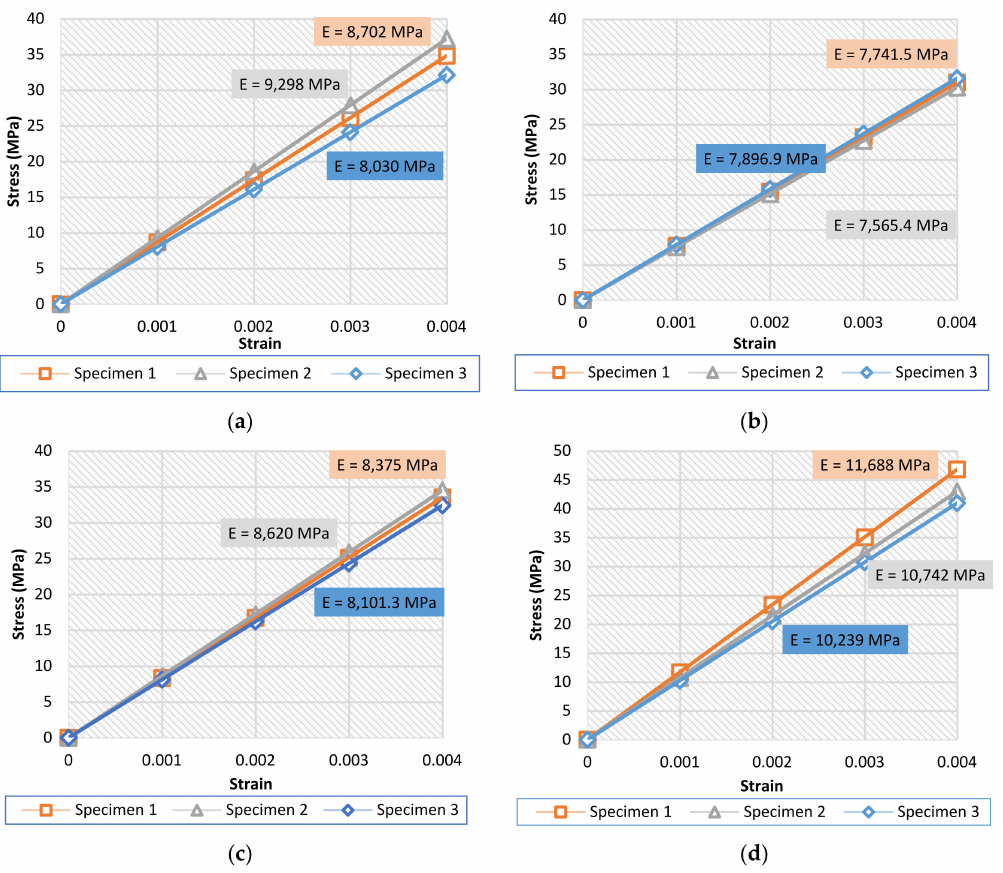
Figure 6. Stress–strain curves with the determined effective Young’s modulus: ( a ) 3D lattice in- fill pattern, ( b ) double-pyramid lattice with cross, ( c ) double-pyramid lattice and face diagonals, ( d ) octahedral lattice 2.